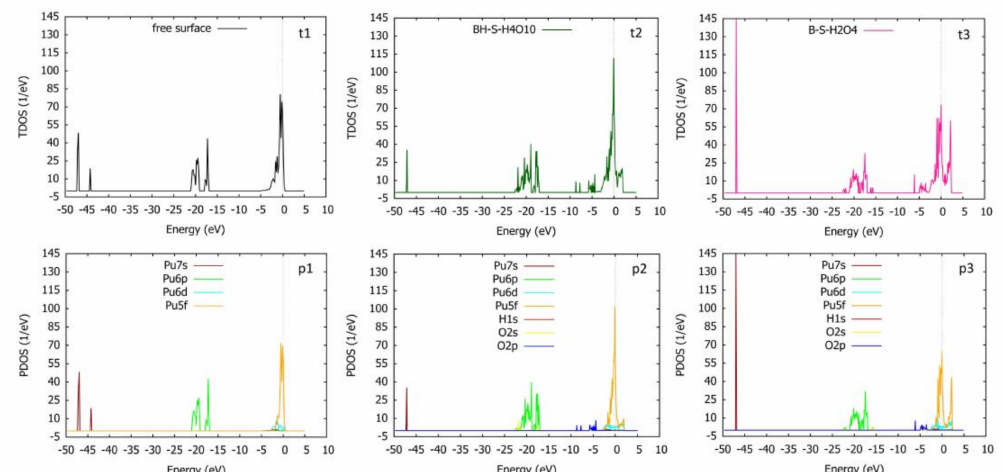
Figure 11. The density of state diagrams of δ -Pu (100) surface before preferential adsorption, the most stable adsorption configuration (BH-S-H4O10) obtained by preferential adsorption of H 2 O and the most stable adsorption configuration (B-S-H2O4) obtained by preferential adsorption of O 2 . t1: total density of states of pure δ -Pu (100) surface, p1: partial density of states of pure δ -Pu (100) surface, t2: total density of states of BH-S-H4O10, p2: partial density of states of BH-S-H4O10, t3: total density of states of B-S-H2O4, p3: partial density of states of B-S-H2O4; the dotted line in the figure represents the position of the Fermi